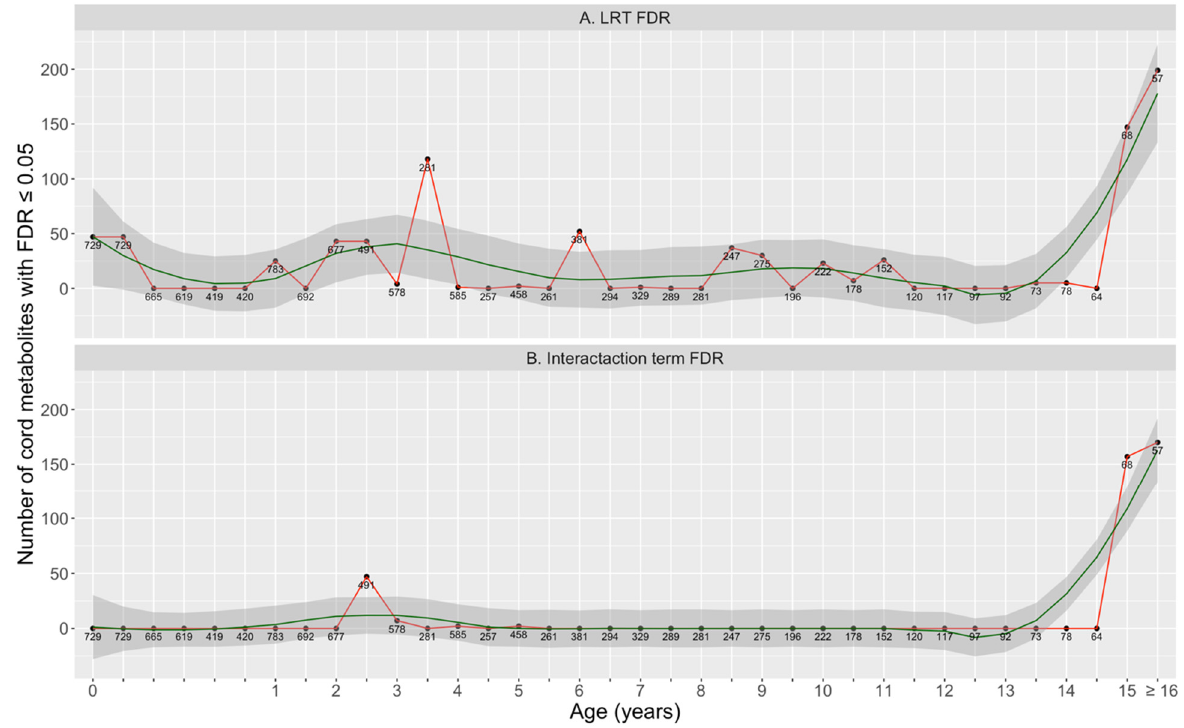
Figure 4. Time-window specific analysis: Number of significant metabolites at each time-window based on LRT FDR ( A ), number of metabolites that have significantly different effects between two sexes at each time-window based on metabolite-by-sex interaction term FDR ( B ). Annotated numbers are the sample size (number of subjects) available at each time-window. Green lines are the LOWESS smoothing curves. Potential critical growth ages (peaks in panel A) are around ages 0 (birth), 1–3.5, 6, 8–11, and ≥